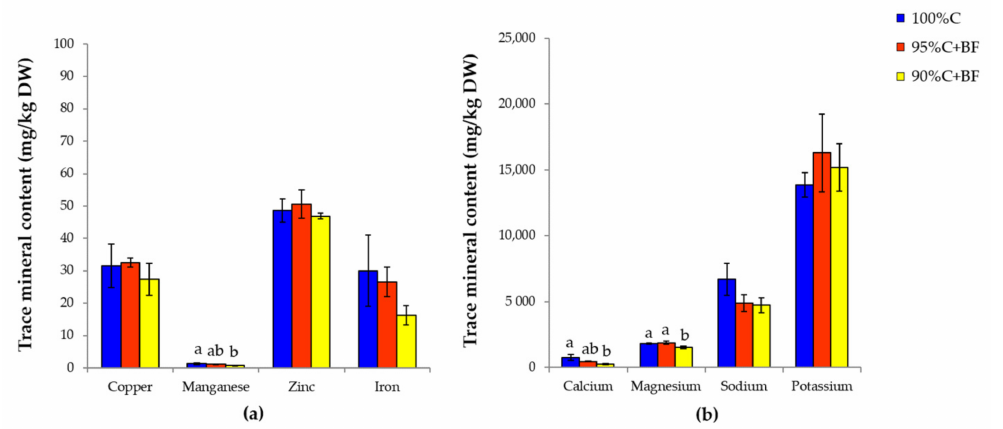
Figure 3. Trace mineral analysis of shrimp-fed with commercial pellet (100%C; blue) and shrimp- supplemented with ex-situ biofloc in different commercial pellet reduction ratios (95%C+BF, red; 90%C+BF, yellow). ( a ) Copper, Manganese, Zinc and Iron, and ( b ) Calcium, Magnesium, Sodium, and Potassium. Error bars represent a value of ± standard derivation. Different letters above bars (a and b) represent a significant difference among the three groups.